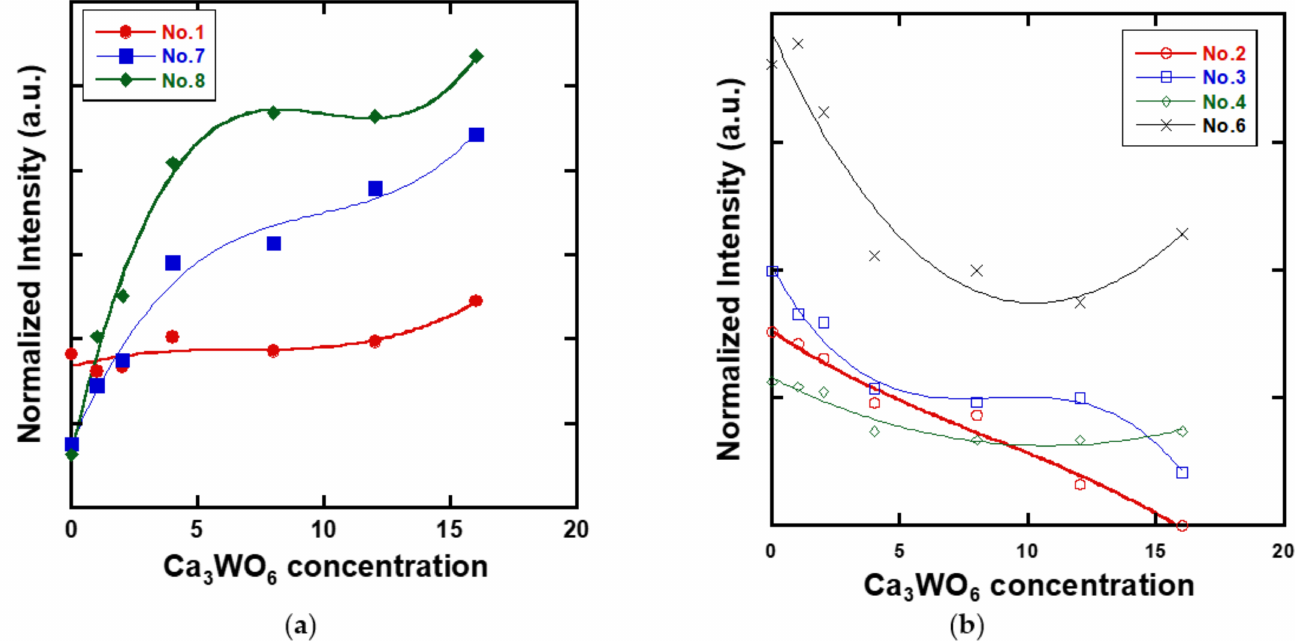
Figure 7. The decomposition peak intensity of ( a ) Nos.1, 7, and 8, and ( b ) Nos.2, 3, 4, and 6 with Ca 3 WO 6 concentration. However, the peak intensity of Nos.1 and 7 exhibited an increasing tendency with Ca 3 WO 6 concentration. Especially, peak No.7 showed a significant increase in comparison with peak No.1. In other words, a more significant change in the peak intensity about W = O double bonding than WO 6 bending mode was observed, implying an increase in the number of W 6+ ions and a structural change to WO 4 tetrahedra was more dominant than to WO 6 octahedra. Thus, the CaWO 4 crystal phase composed of WO 4 tetrahedra would be precipitated after the heat-treatment, instead of the Ca 3 WO 6 crystal phase with WO 6